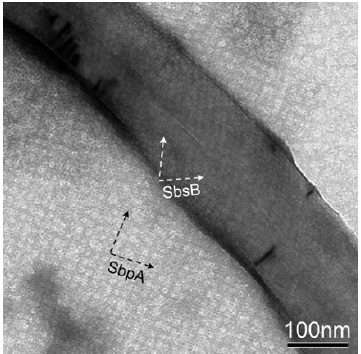
Figure 3. TEM image of the heterologous reassembly of SbpA and SbsB S-layer proteins in a pristine MWNT solution. SbsB covers the nanotube surface (white arrows), while SbpA forms self-assembled sheets (black arrows).